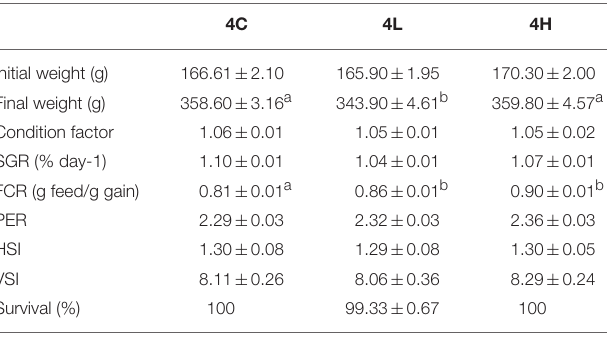
TABLE 3 | Growth, feed performance, organosomatic indices and survival rate of Atlantic salmon from the different groups.